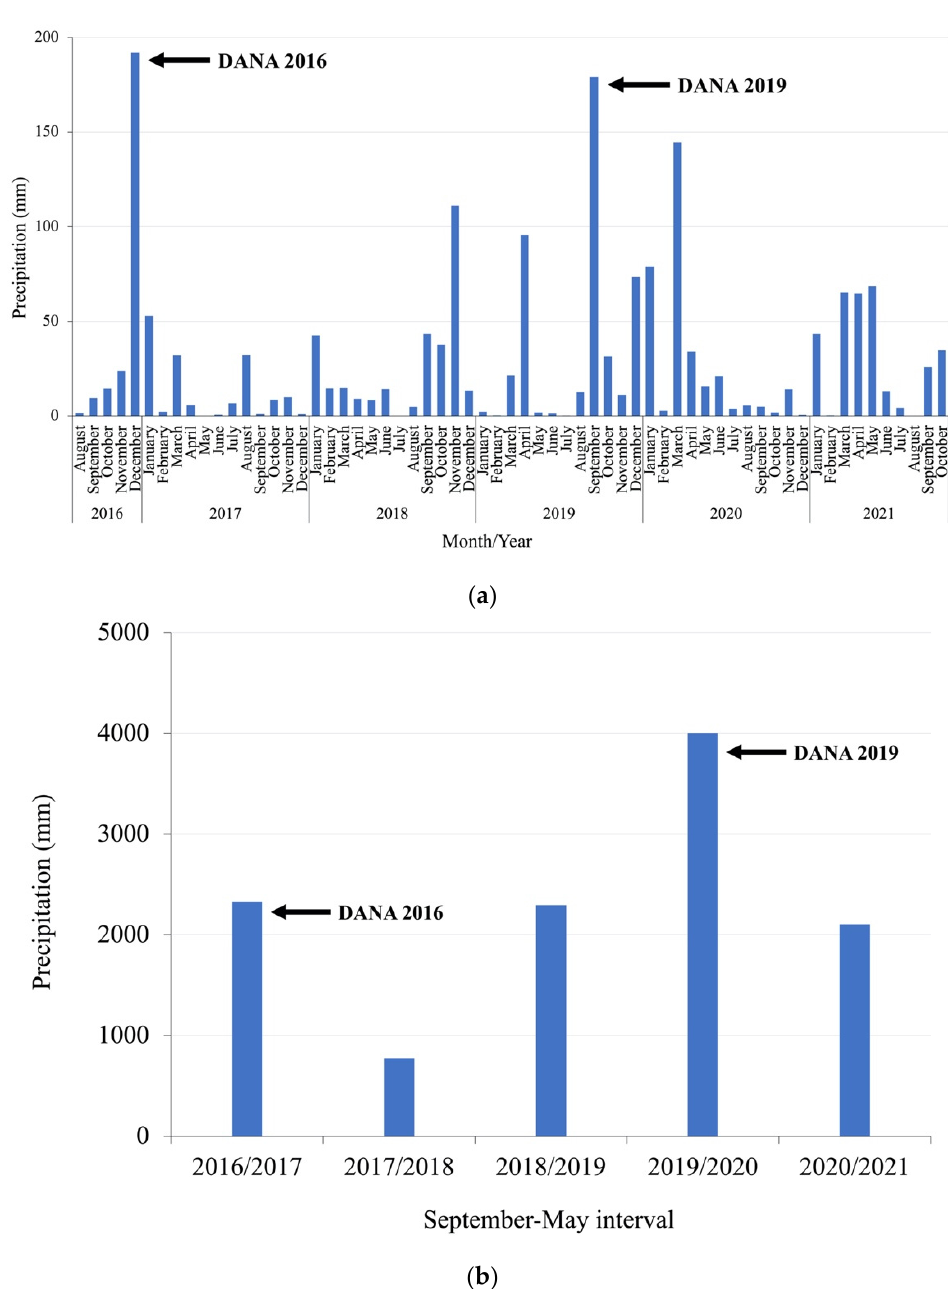
Figure 2. ( a ) Mean monthly rainfall for the 7 stations around the Mar Menor area from 2016 to 2021; ( b ) Precipitation values from September to May between 2016 and 2021.